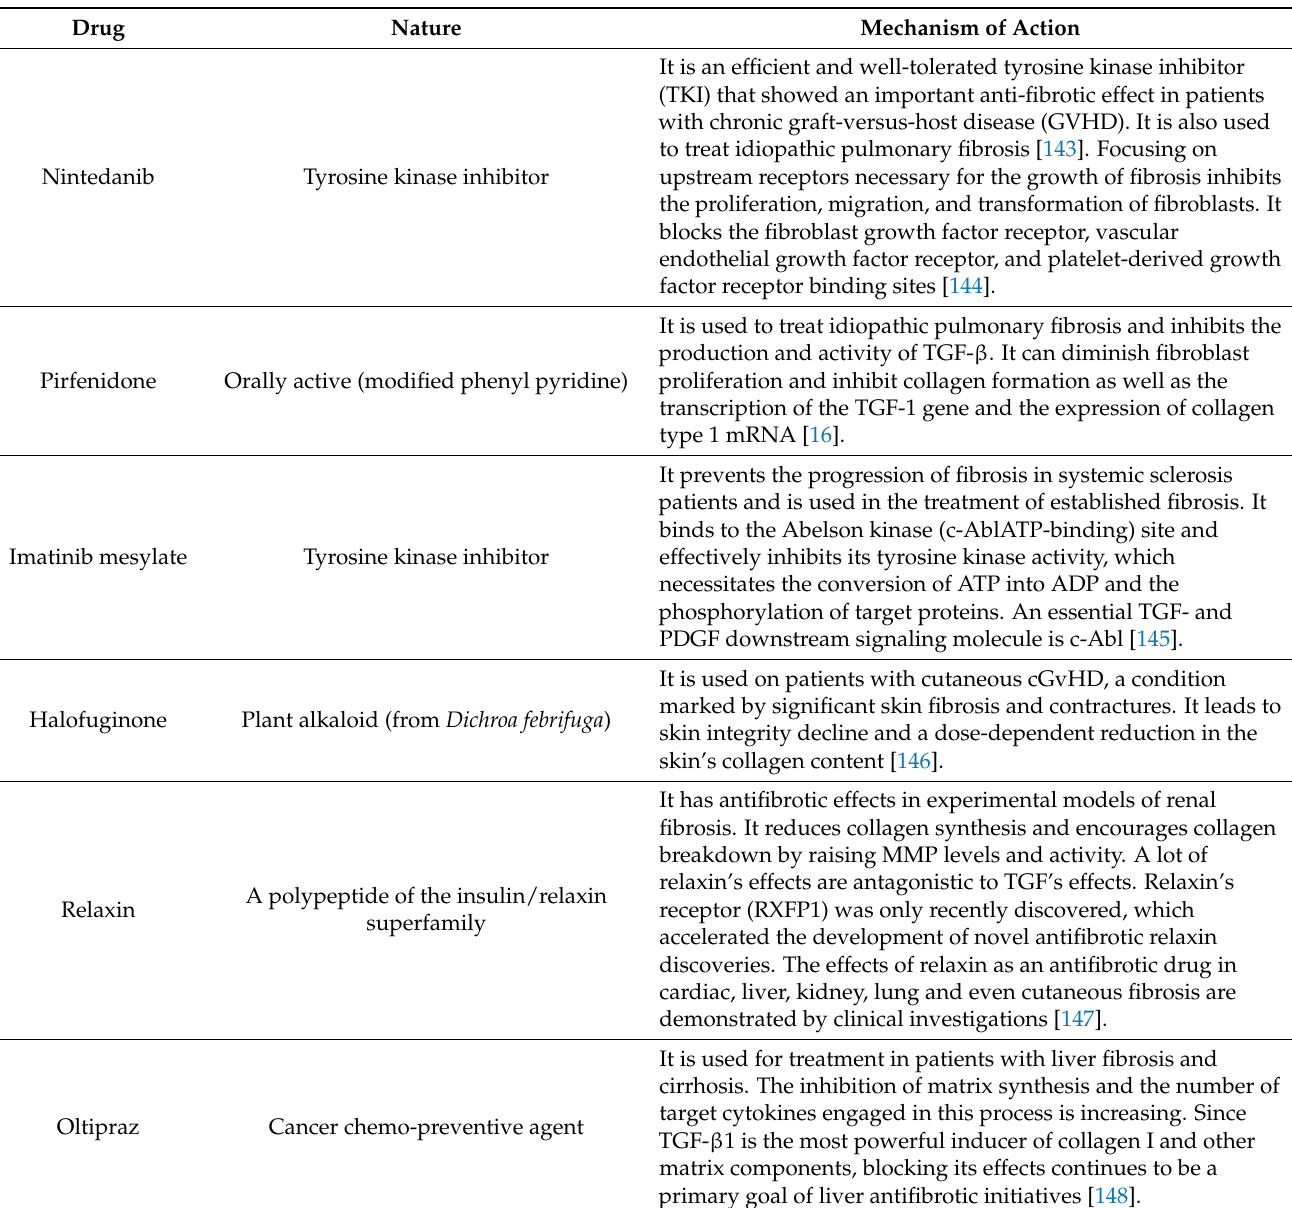
Table 2. Examples of antifibrotic